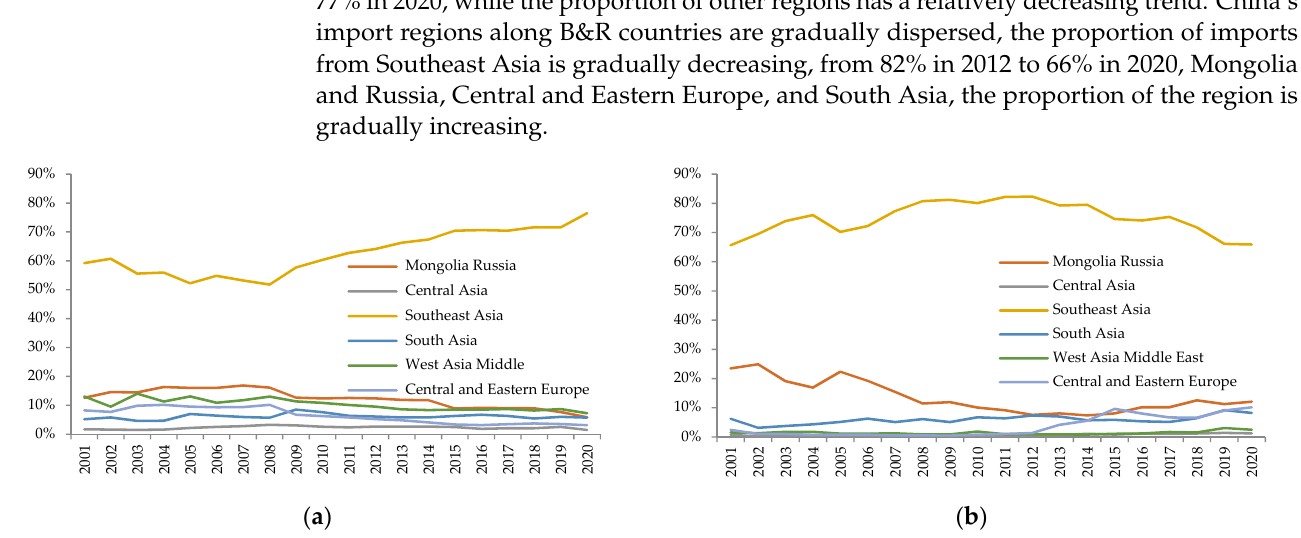
Figure 2. ( a ) China exports agricultural to B&R countries regional distribution; ( b ) China imports agricultural to B&R countries regional distribution. Data Source: UN COMTRADE database.